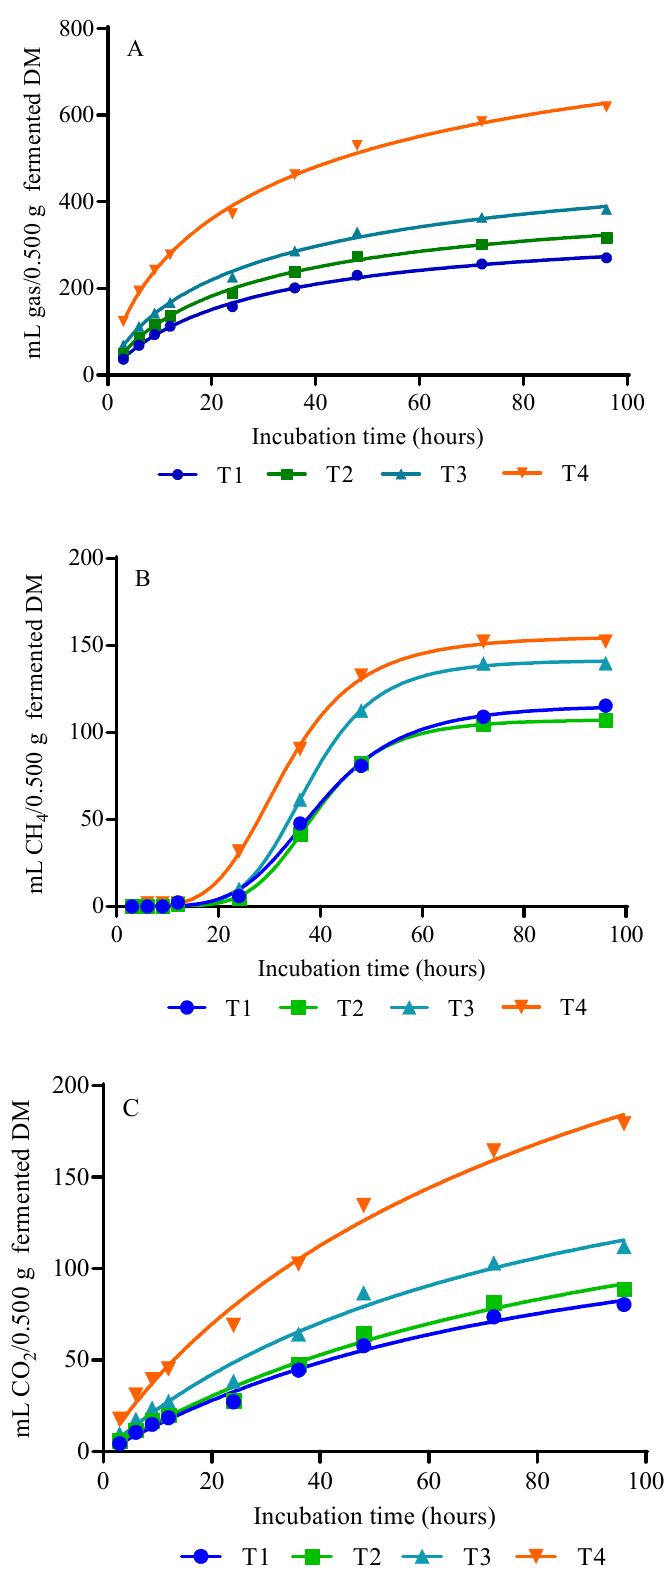
Figure 1. Gas ( A ), CH 4 ( B ), and CO 2 ( C ) production kinetics of diets with increasing levels of